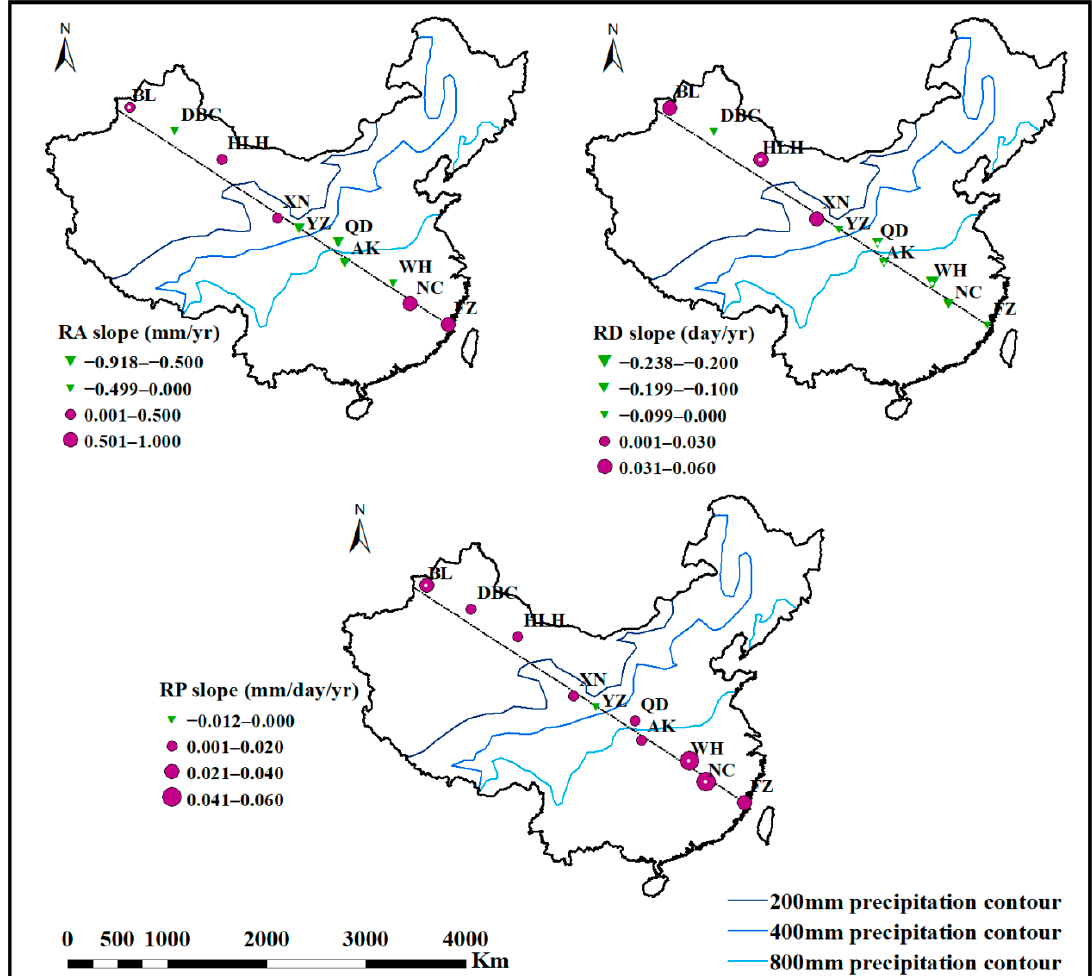
Figure 5. The Mann-Kendall trend test and Sen’s slope were used to reflect the variation trends for the autumn precipitation indices, including rainfall amount (RA), rainfall days (RD), and daily precipitation on rainy days (RP). Note: white spots mean precipitation change trend reached the significance level of 95% confidence for the MK trend test.